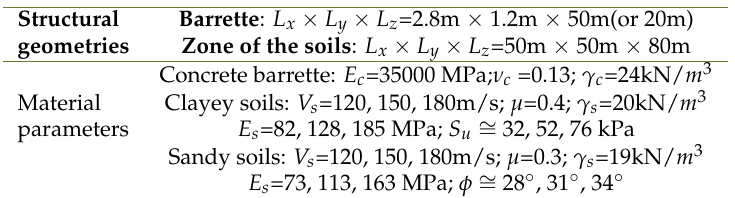
Table 1. Structural geometries and material parameters of the numerical model Structural